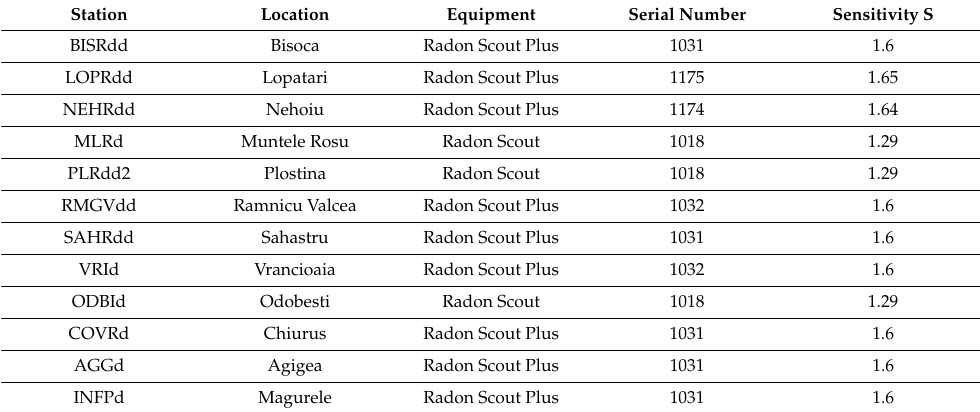
Table 5. Radon Scout PLUS and Radon Scout sensitivity S (cts/min*kBq/m 3 ). Station